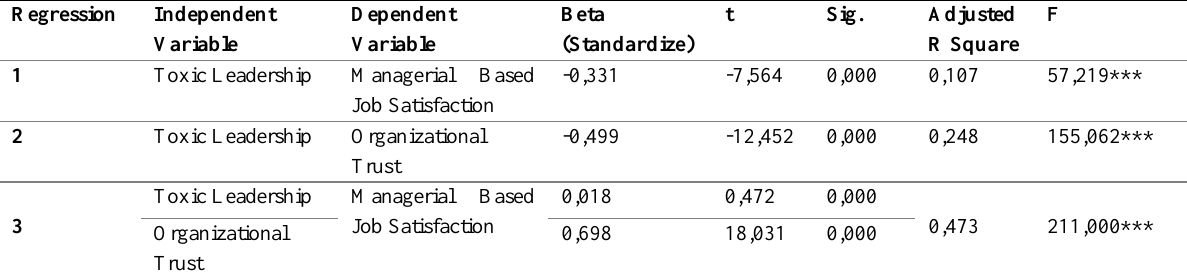
Table 6: The Effect of Toxic Leadership on Managerial Based Job Satisfaction through the Mediation of Organizational Trust